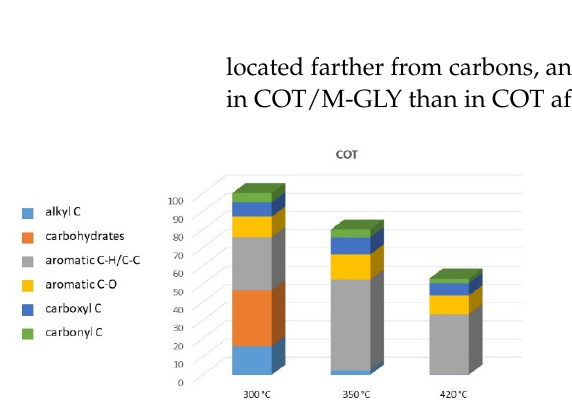
Figure 9. Relative intensity of alkyl (0–60 ppm), carbohydrate (60–110 ppm), unsubstituted, H, and alkyl substituted aromatics (110–146 ppm), OH and OR substituted aromatics (146–165 ppm), carboxyl (165–185 ppm), and carbonyl (185–220 ppm) signals in the spectra reported in Figure 8. The integral intensities were normalized with respect to number of scans and sample weight and referred to COT treated at 300 °C.